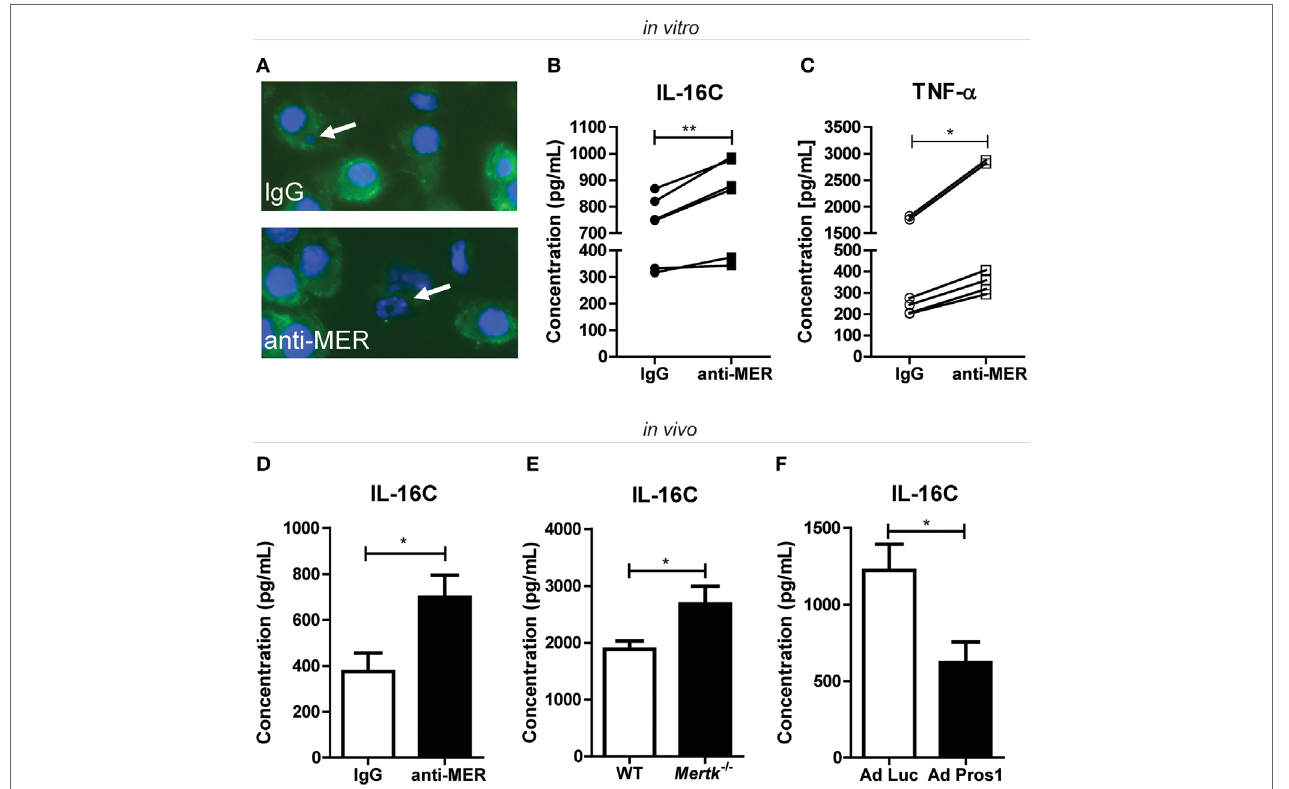
FigUre 6 | Assessment of secondary necrosis after treatment with MER-specific antibodies, Mertk gene ablation or Pros1 overexpression. (a) J774A.1 cells were incubated with IgG or anti-MER and cocultured with bone marrow neutrophils for 24 h. Cells were stained with F4/80 (green) and DAPI (blue). Representative pictures are shown for each group. White arrows indicate an engulfed cell (IgG group) or an apoptotic cell (anti-MER group). (b) J774A.1 cells were incubated with IgG or anti-MER and cocultured with bone marrow neutrophils for 48 h. Supernatants were examined for the presence of interleukin (IL)-16C ( n = 6 individual experiments). (c) Supernatants of (b) were analyzed for the presence of tumor necrosis factor alpha (TNF- α ) ( n = 6 individual experiments). (D) Serum samples from collagen-induced arthritis (CIA) mice systemically treated with IgG or anti-MER were analyzed for IL-16C ( n = 10–11 mice). (e) Serum samples from wild-type (WT) or Mertk − / − mice with KRN serum transfer arthritis were analyzed for IL-16C ( n = 9–15 mice). (F) Serum samples from mice with CIA intravenously injected with Ad Luc or Ad Pros1 were analyzed for IL-16C ( n = 7–8 mice). For (b,c) , data are presented as dot-plots. * p < 0.05, ** p < 0.01 with paired t -test. For (D–F) , data are presented as mean + SEM. * p < 0.05 with unpaired t -test. See also Figure S5 in Supplementary